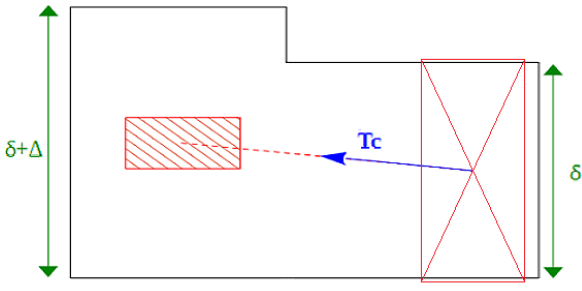
Figure 6: Incorrect inner-fit polygon.